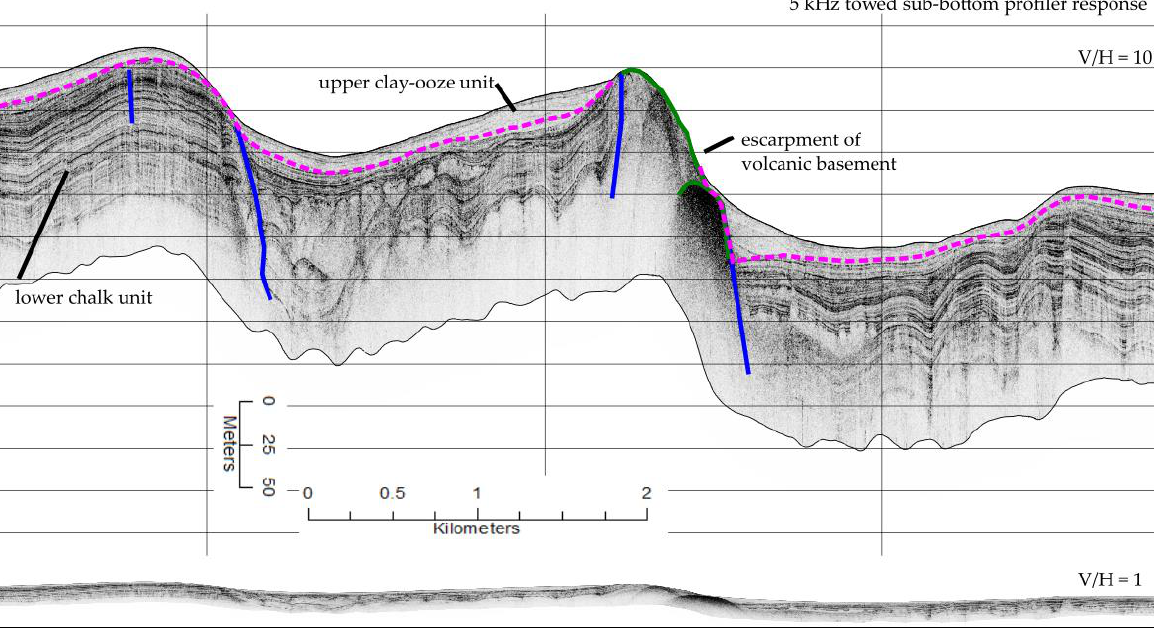
Figure 10. Example sub-bottom profiler image of the host/basement for the nodule deposit.